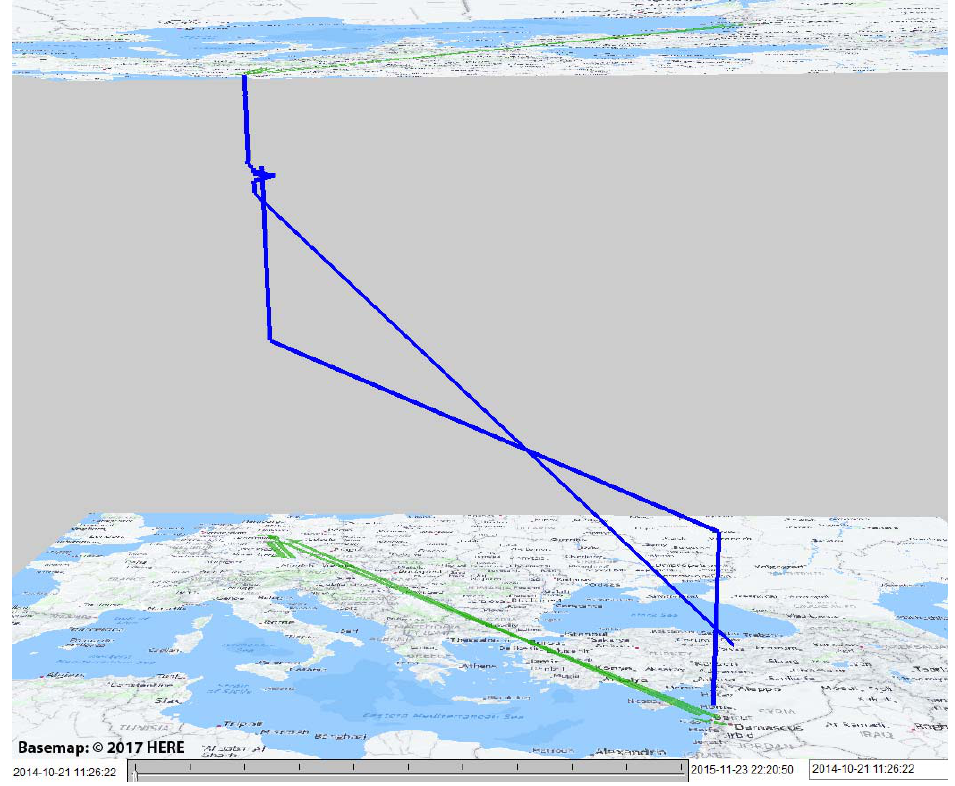
Figure 8. Two likely identified refugee trajectories (blue) and their generalization as routes (green) to Europe visualized in a space-time cube.